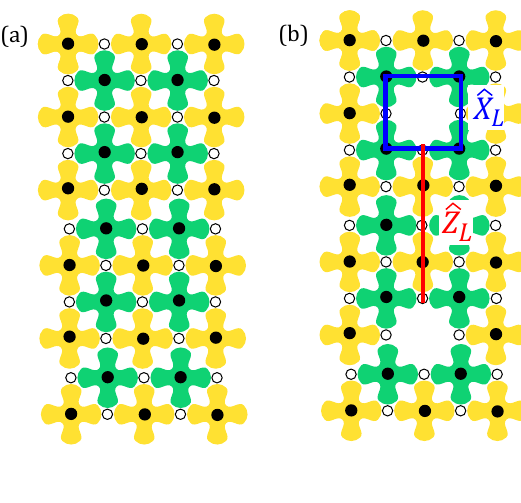
Figure 30: “Easy” initialization of an X-cut logical qubit, where the stable measure-X outcome just prior to creating the qubit hole is equal to the initial logical eigenvalue of the qubit. Figure from Ref. (Fowler, Mariantoni, Martinis and Cleland,